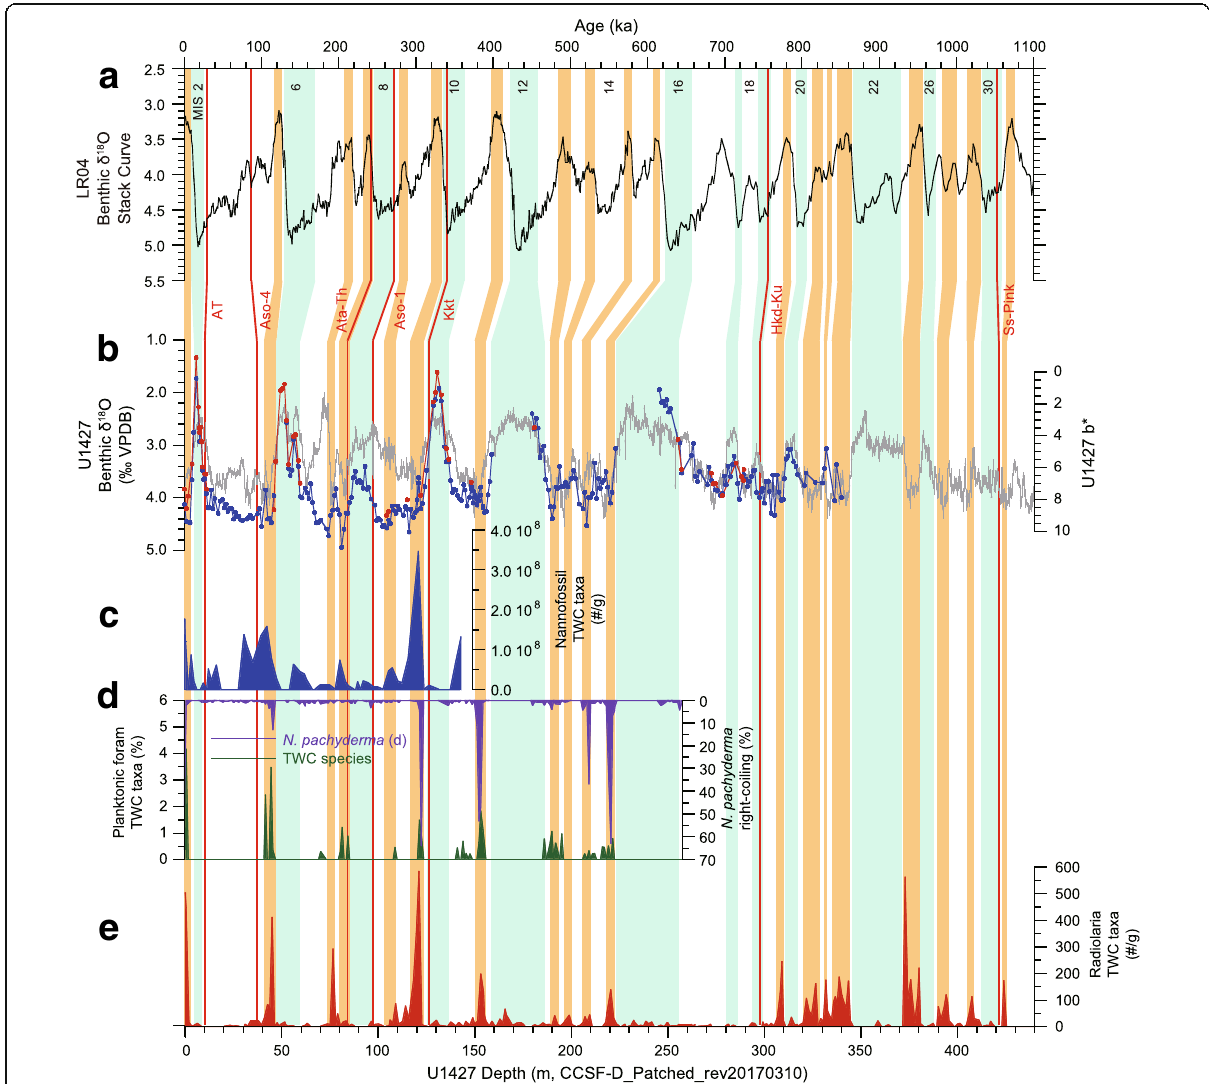
Fig. 7 Summary correlation of Site U1427 records with the LR04 stack. a LR04 benthic isotope stack. b U1427 benthic foraminiferal δ 18 O values and sediment color b* variation. Abundance of TWC taxa of three planktonic groups, c calcareous nannofossils, d planktonic foraminifera, and e radiolaria. Background color indicates correlation of glacial and interglacial maxima, which are defined by benthic δ 18 O measurements and TWC indicators, respectively. Red lines indicate age constraints from well-known regional tephra